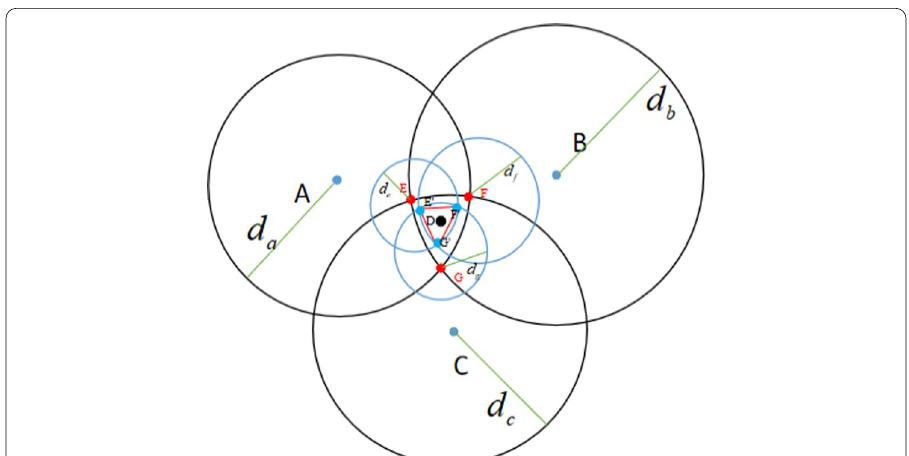
Fig. 2 The improved triangle centroid localization algorithm (ITCL-PIT) model. This figure shows how to calculate the coordinate of the unknown node under the improved triangle centroid localization